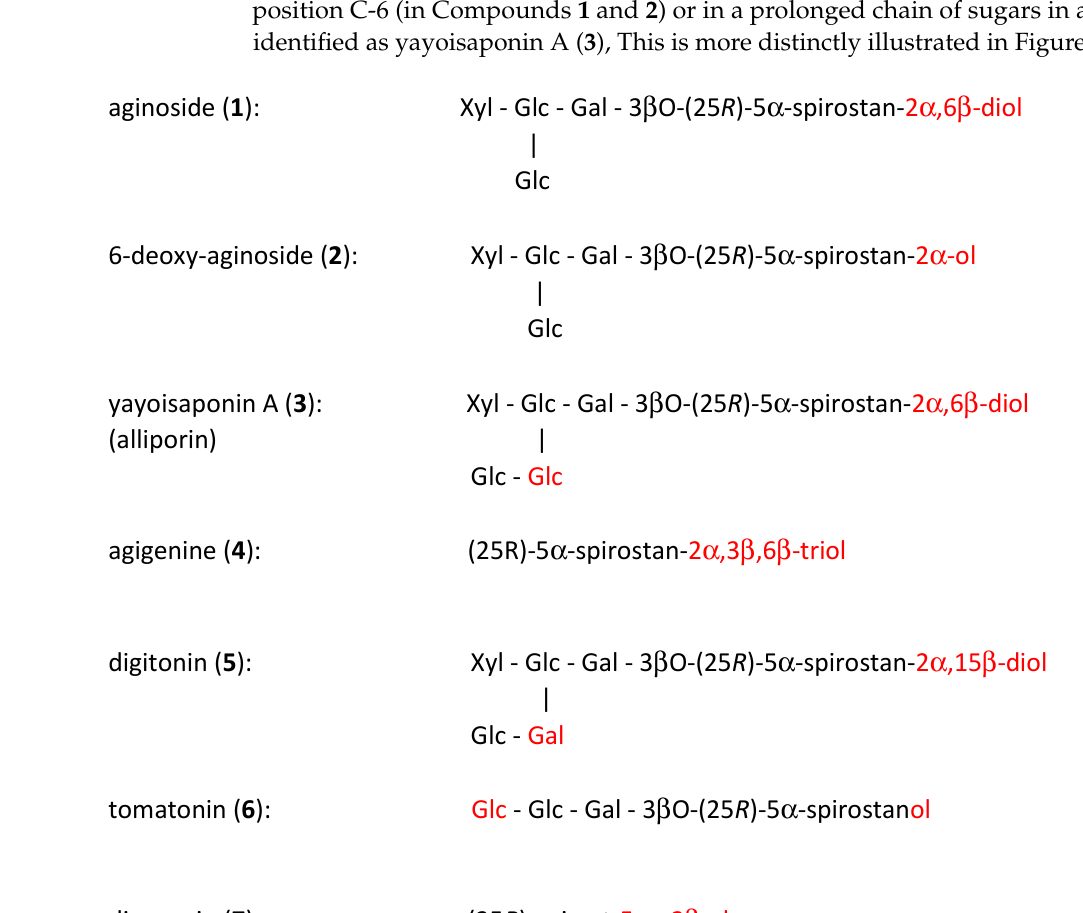
Figure 2. Schematic illustration of structural relations between the native leek-flower Compounds 1 – 4 and selected standard compounds 5 – 7 . Related saponins 5 and 6 , and aglycone 7 were selected for comparative bioactivity testing.